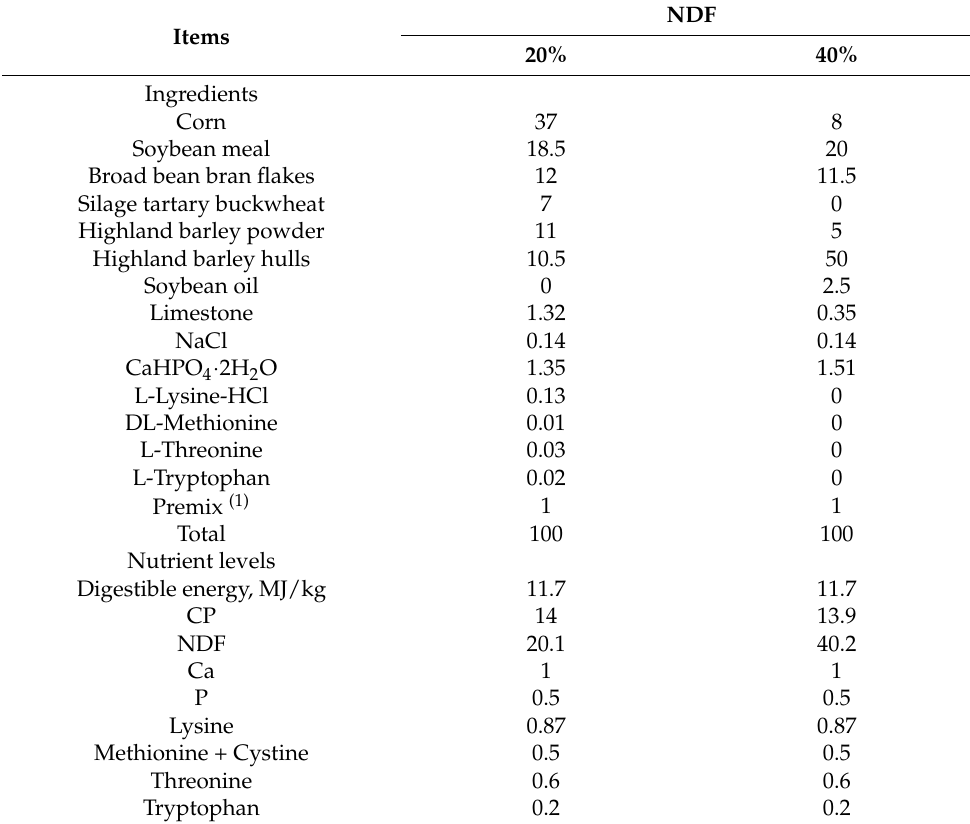
Table 1. Composition and nutritional level of experimental diet (air-dry basis),